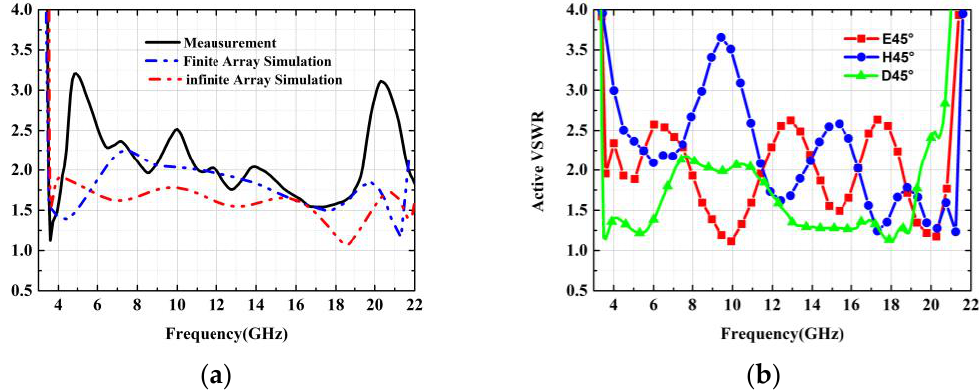
Figure 5. Measured and simulated VSWR of ( a ) active broadside ( b ) scans along the E-/H-/D- planes.